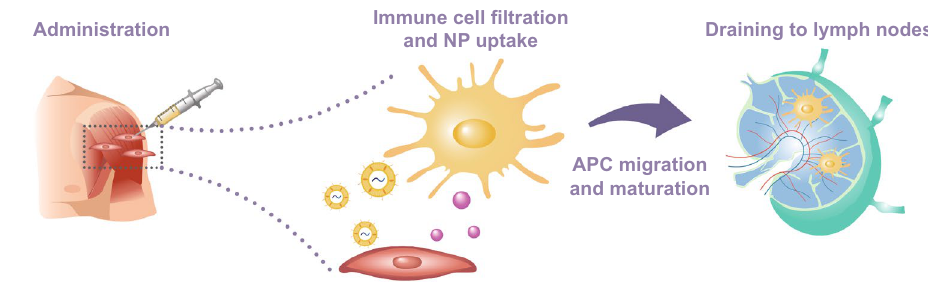
Fig. 1 Schematic representation of vaccine administration, nanoparticle uptake by immature APCs, and subsequent migration to lymph nodes through the lymphatic